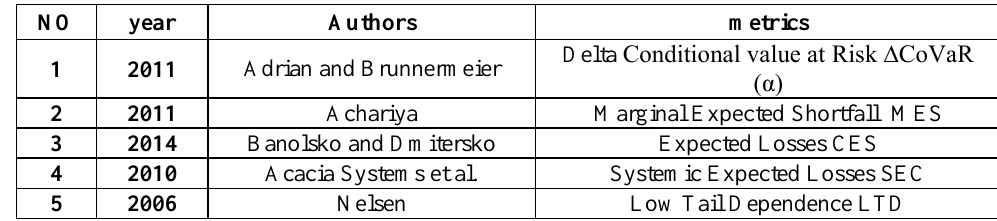
Table 1. Summary of information on widely used systemic risk